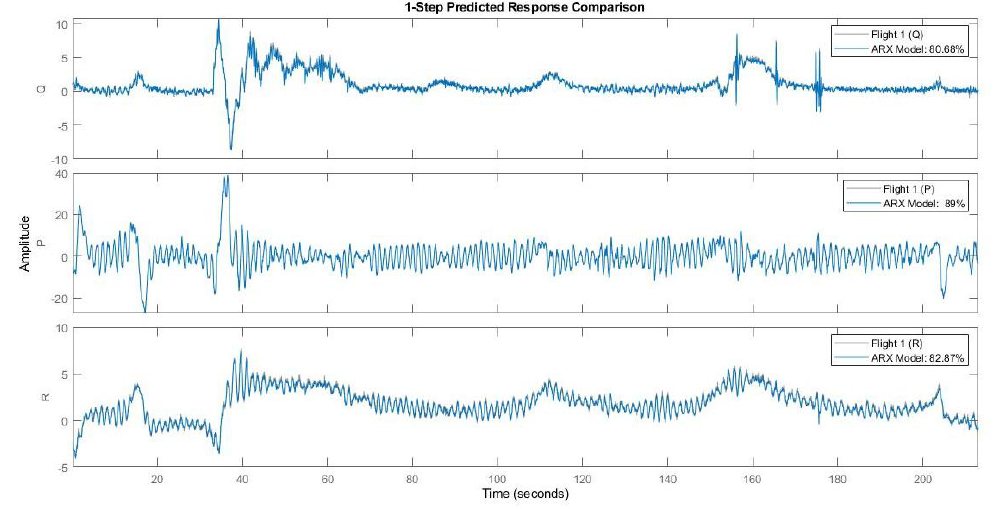
Figure 10. ARX Model